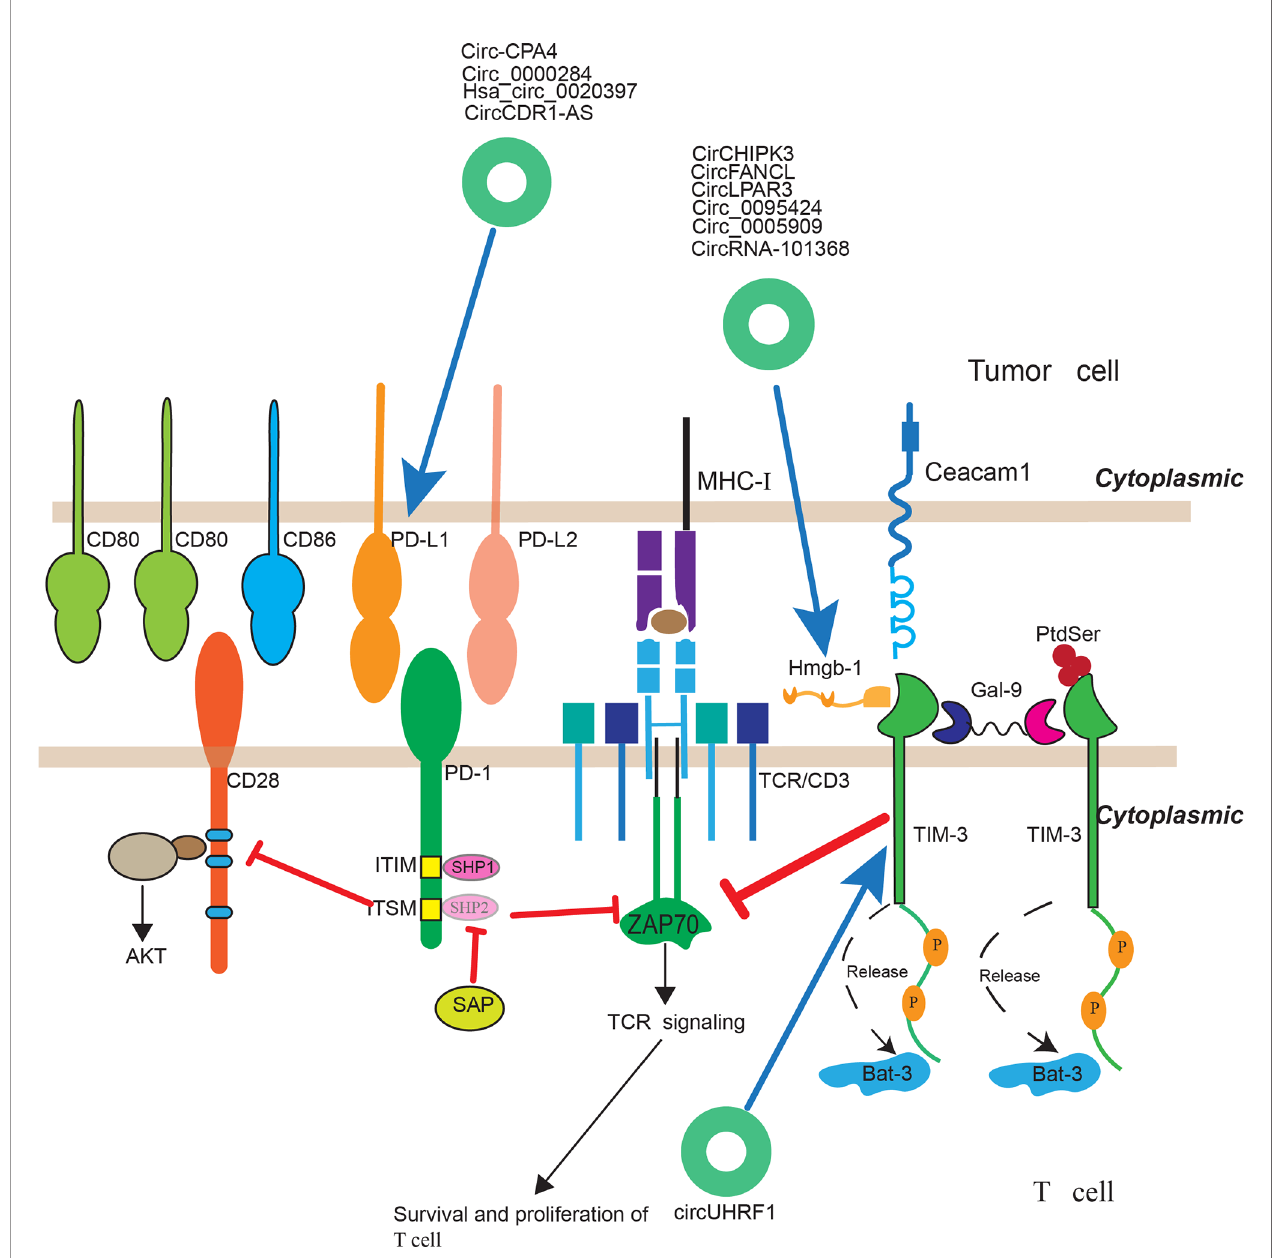
FIGURE 2 | The regulatory roles of circRNAs in immunotherapy. CircRNAs have been implicated to play a regulatory role of immune checkpoints and have the potential to serve as a predictive biomarker of immune checkpoint